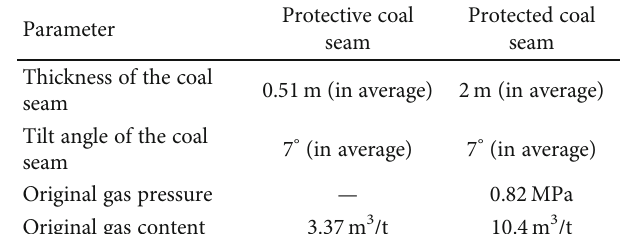
Figure 1: Working faces layouts. Table 1: Basic parameters of the coal seams.